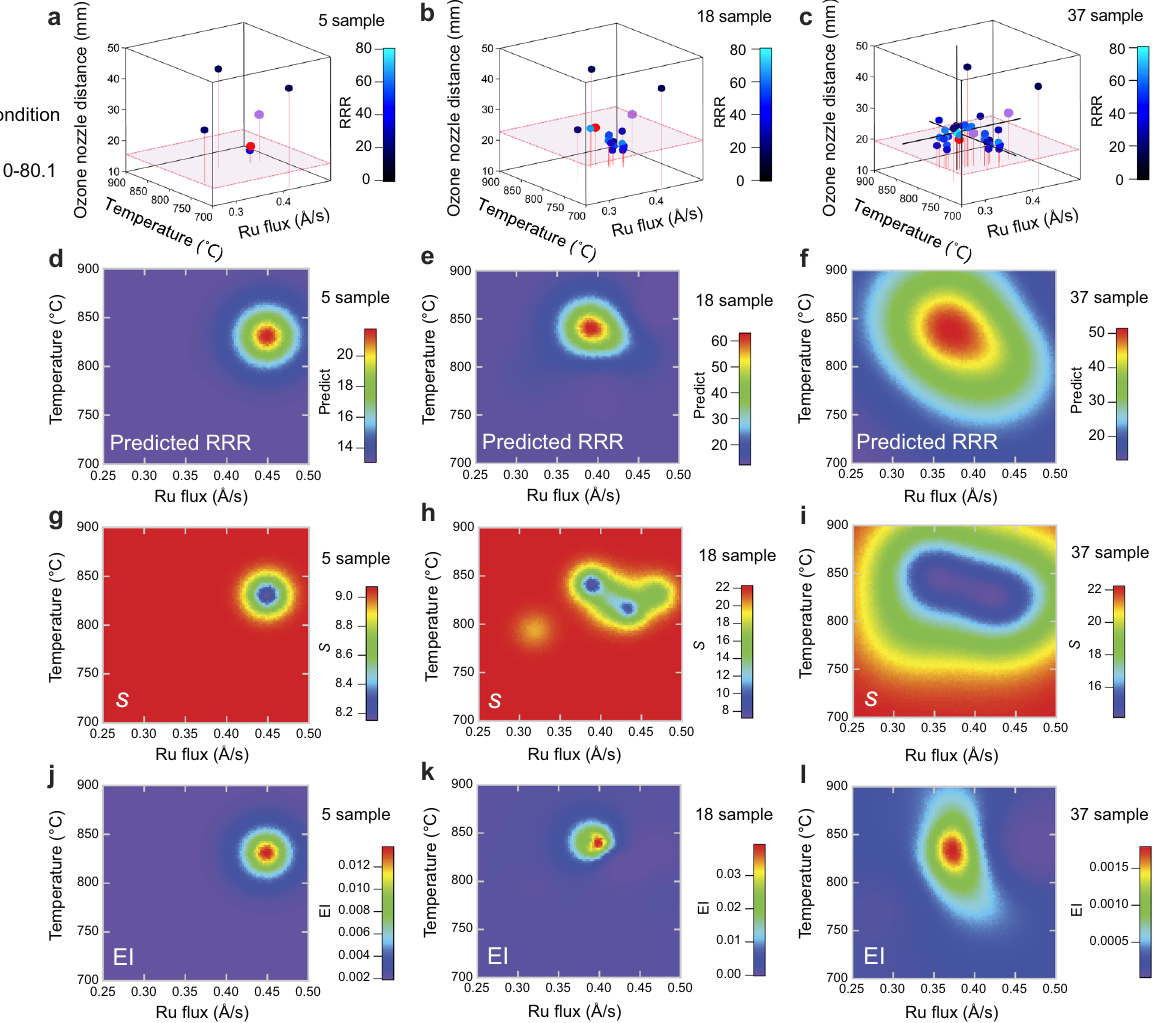
Fig. 6 Experimental RRR values and prediction results from GPR. a – c Experimental RRR values in the three-dimensional growth parameter space for 5 ( a ), 18 ( b ), and 37 ( c ) samples. The purple spheres indicate the NaN points at which the SrRuO 3 phase was not obtained. The red spheres indicate the next conditions at which the highest EI values were obtained. The red planes indicate the cutting plane of the O 3 -nozzle- to-substrate distance, at which the highest EI value was obtained. d – l Two-dimensional plots of predicted RRR values ( d – f ), standard deviation s values ( g – i ), and EI values ( j – l ) at the O 3 -nozzle-to-substrate distance of 15.5 mm ( d , g , j ), 22.5 mm ( e , h , k ), and 19. 5 mm ( f , i , l ), which were obtained from the collected data for 5 ( d , g , j ), 18 ( e , h , k ), and 37 ( f , i , l ) samples, respectively. The O 3 -nozzle-to-substrate distance was that at which the highest EI value was